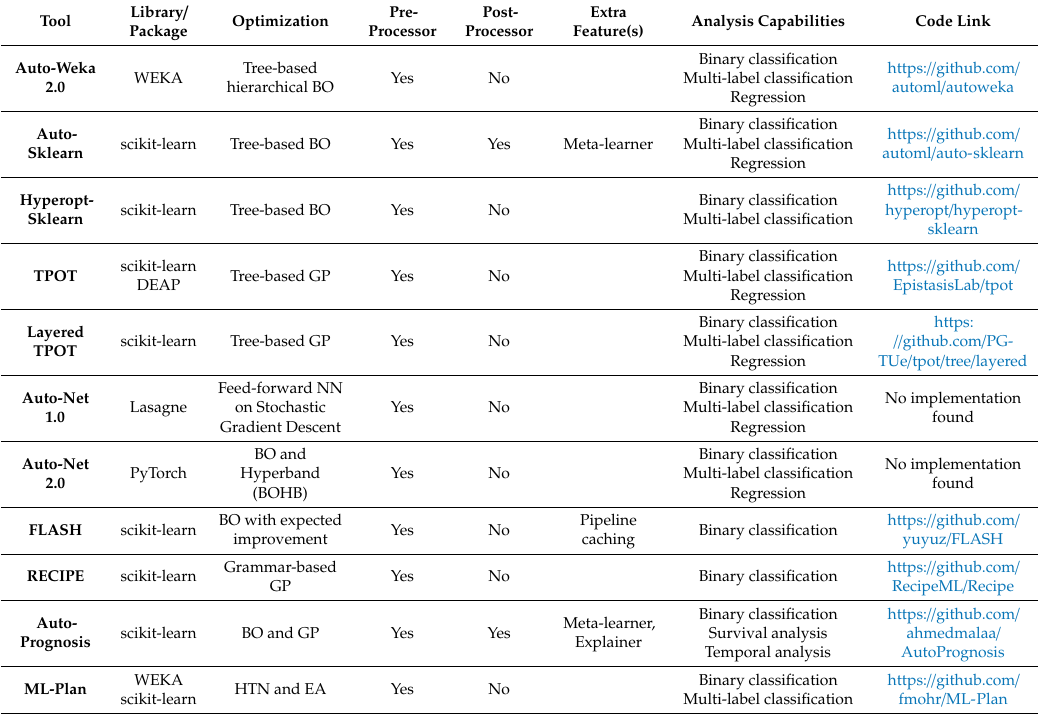
Table A1. Overview of Automated Machine Learning (AutoML)